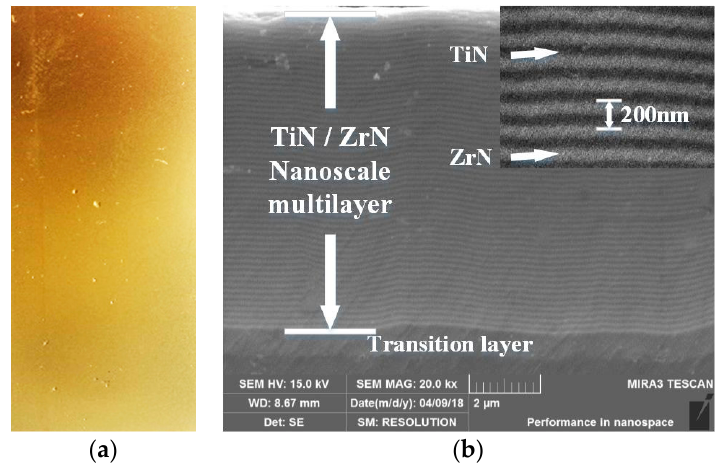
Figure 3. The morphology of ( a ) surface of the coating and ( b ) cross section.